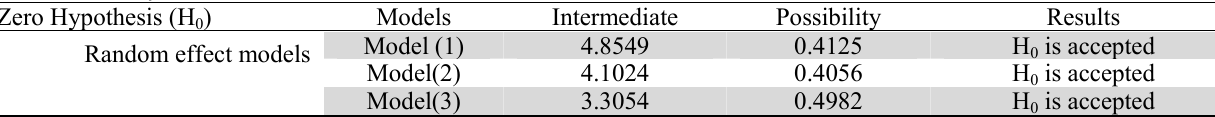
The summary of Hausman test